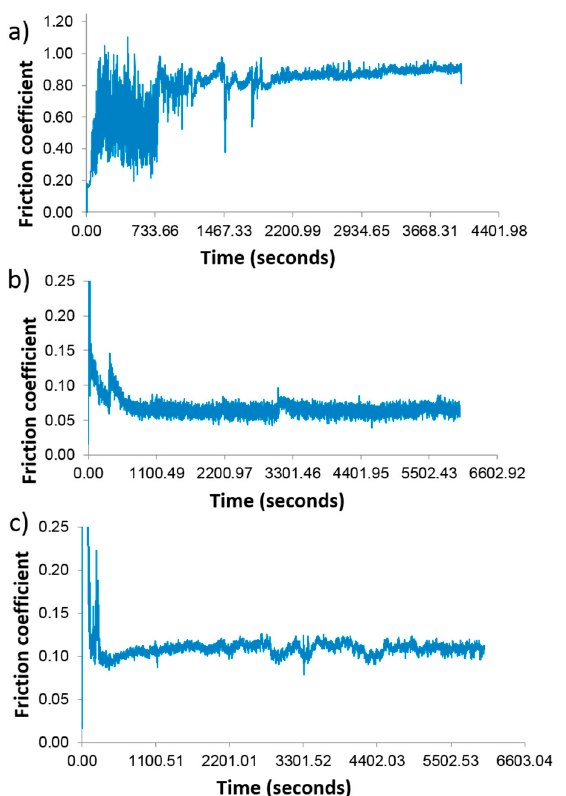
Figure 10. Friction coefficients of the uncoated reference substrate sample ( a ), ta-C DLC coating ( b ), and WC:C DLC coating ( c ).